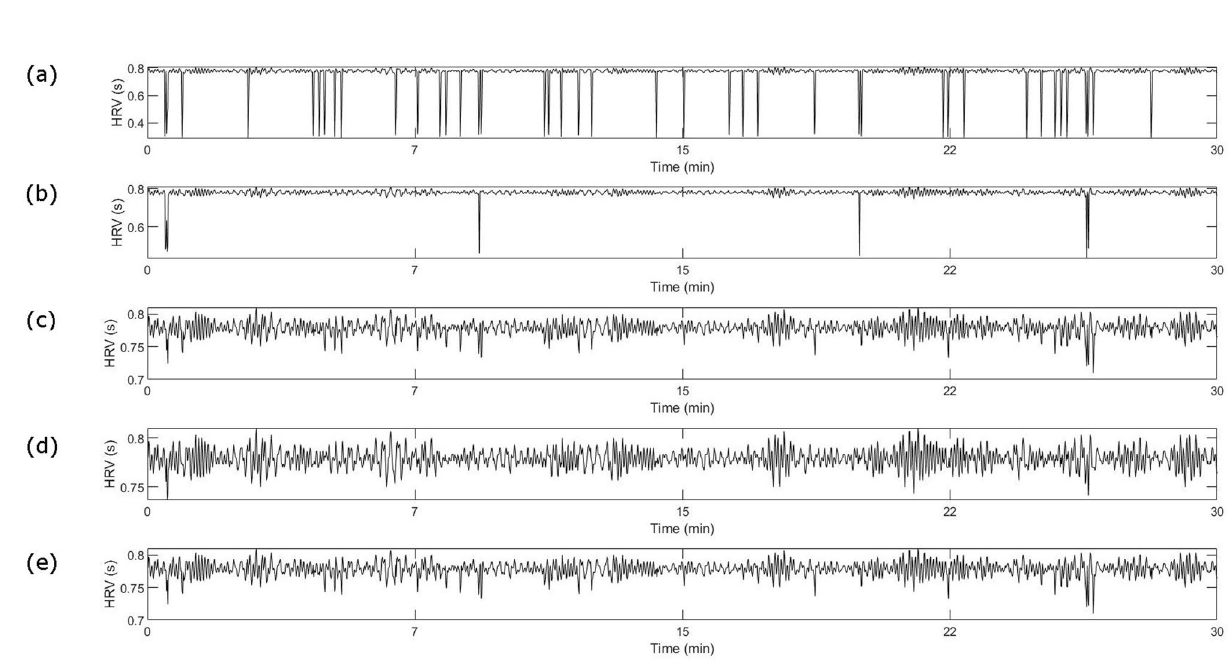
Figure 3. Comparison of different ectopic filters, ( a ) Artificial RR interval with 2% of ectopic beats, ( b ) Denoised RR interval by SDROM, ( c ) Denoised RR interval by ADF, ( d ) Denoised RR interval by combination filter SDROM-ADF, ( e ) Denoised RR interval by combination filter